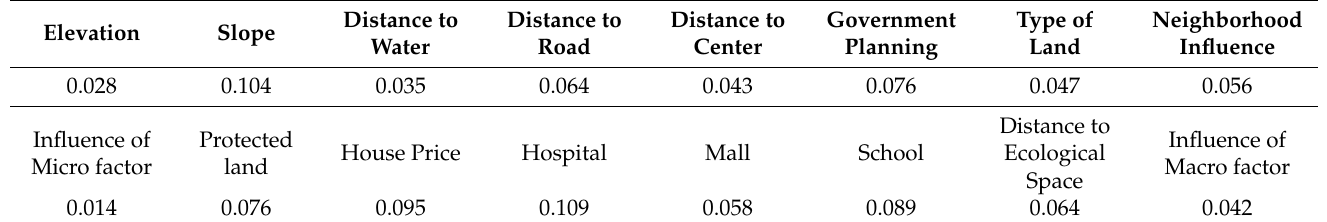
Table 5. Initial weight determination results of factors in living space evolution simulation.